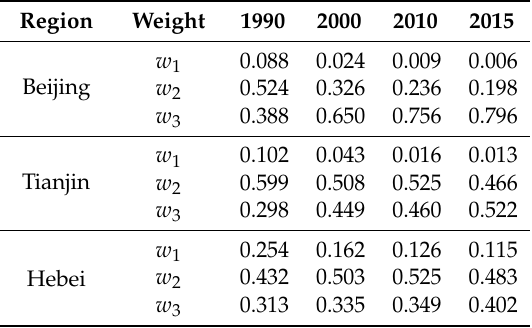
Table A1. Weight of the ecosystem service load for each